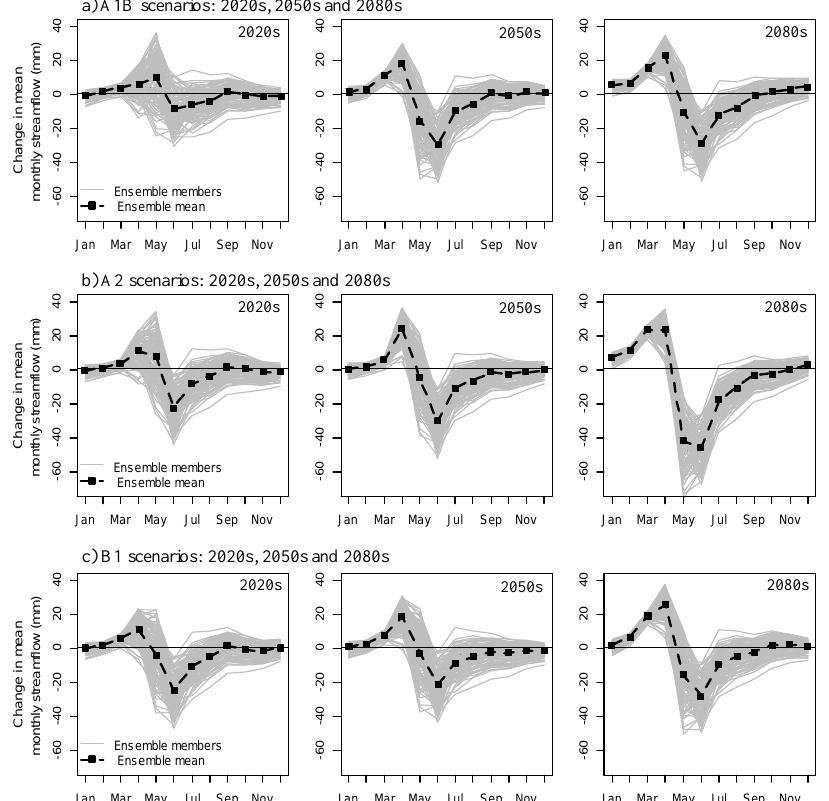
Fig. 10. Ensemble of relative changes in mean monthly streamflows in different future periods compared to reference period streamflow; and mean of the